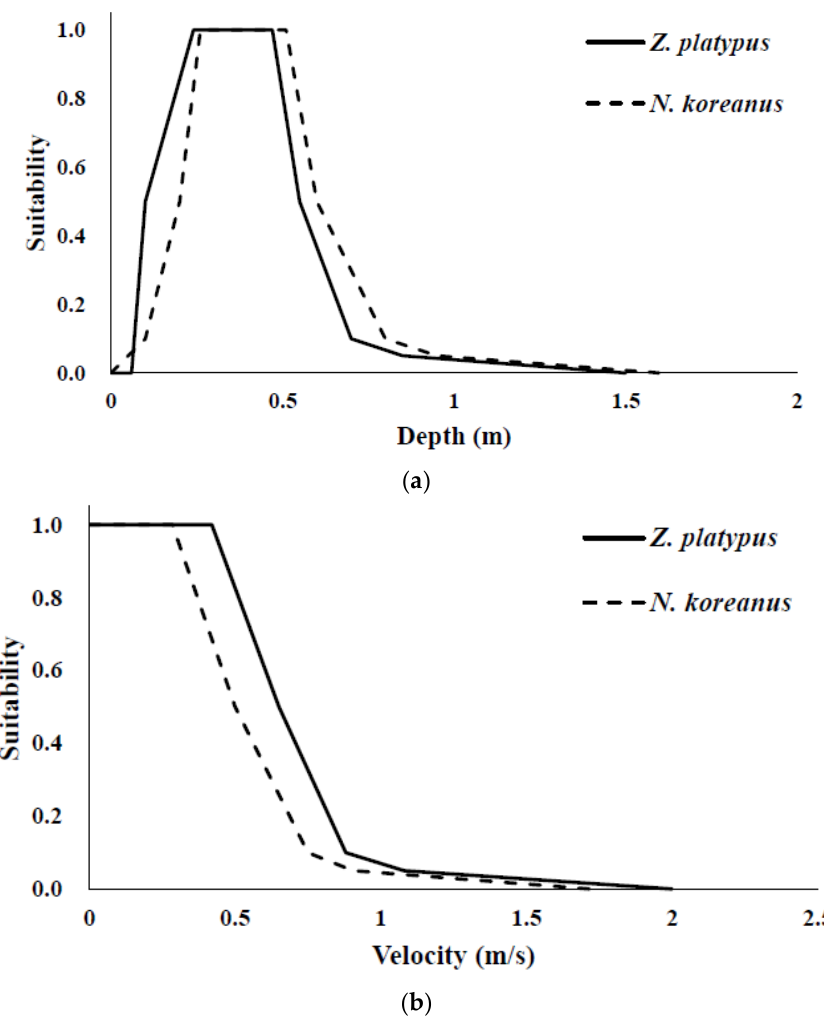
Figure 2. Hydraulic suitability curves for Zacco platypus and Nipponocypris koreanus : ( a ) water depth and ( b ) velocity (reprinted from the work of Kang [47]). The central 50, 75, 90, and 95% of fish abundance data was defined as a suitability of 1, 0.5, 0.1, and 0.05, respectively. Growth and stress curves of Z. platypus and N. koreanus were developed (Figure 3), according to the method described in a previous study [33]. Fish monitoring data from 2008 to 2016 collected from the Water Environment Information System (http://wa- ter.nier.go.kr, accessed on 27 August 2018) were used to derive growth and stress param- eters (Table S1). The lower (G1) and upper (G2) optimum temperatures for growth were defined as the points that contained central 50% of the fish monitoring data [48]. Further- more, the lower (G0) and upper (G3) threshold temperatures for growth were defined as the points that contained central 90% of the data [48].